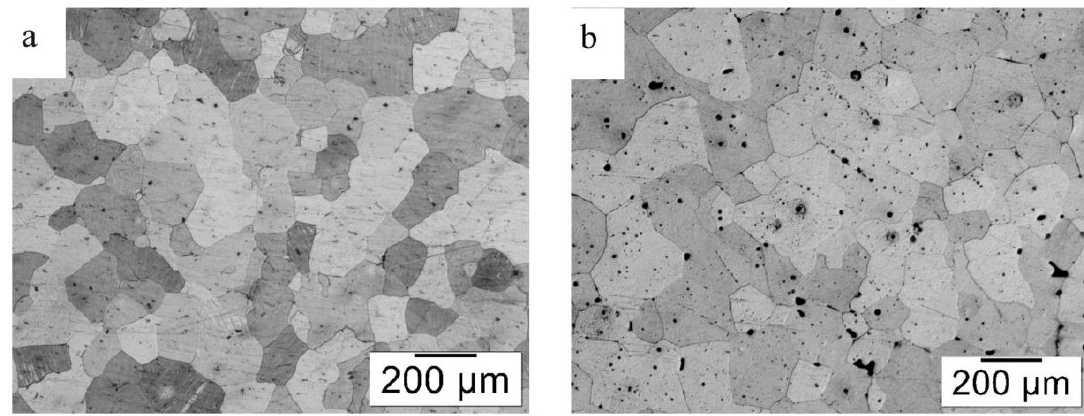
Figure 2. Optical microstructure of ( a ) H-0.4Mg and ( b ) L-1.4Mg alloys at peak-aged state.